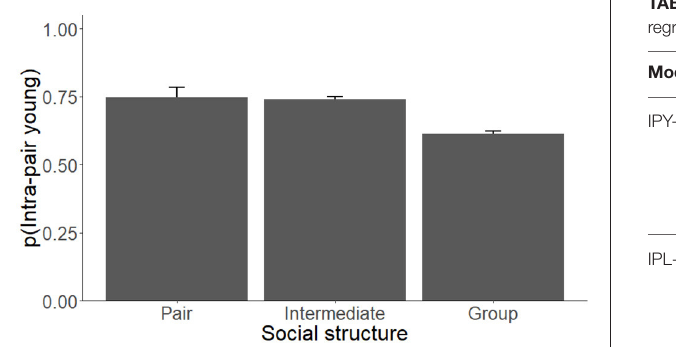
TABLE 3 | Model coefficients and standard errors from the top phylogenetic regression models explaining three indices of genetic monogamy (GM).